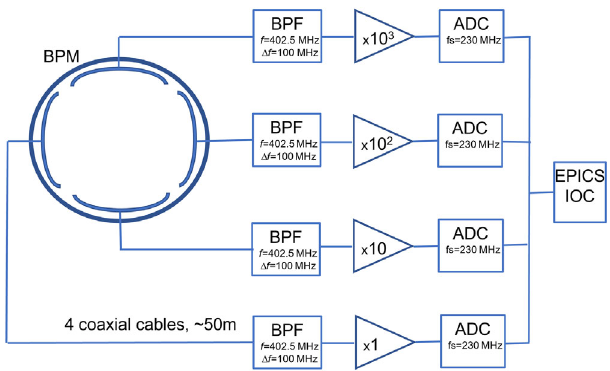
FIG. 6. A block diagram of the high-sensitivity beam current monitor HSBCM signal